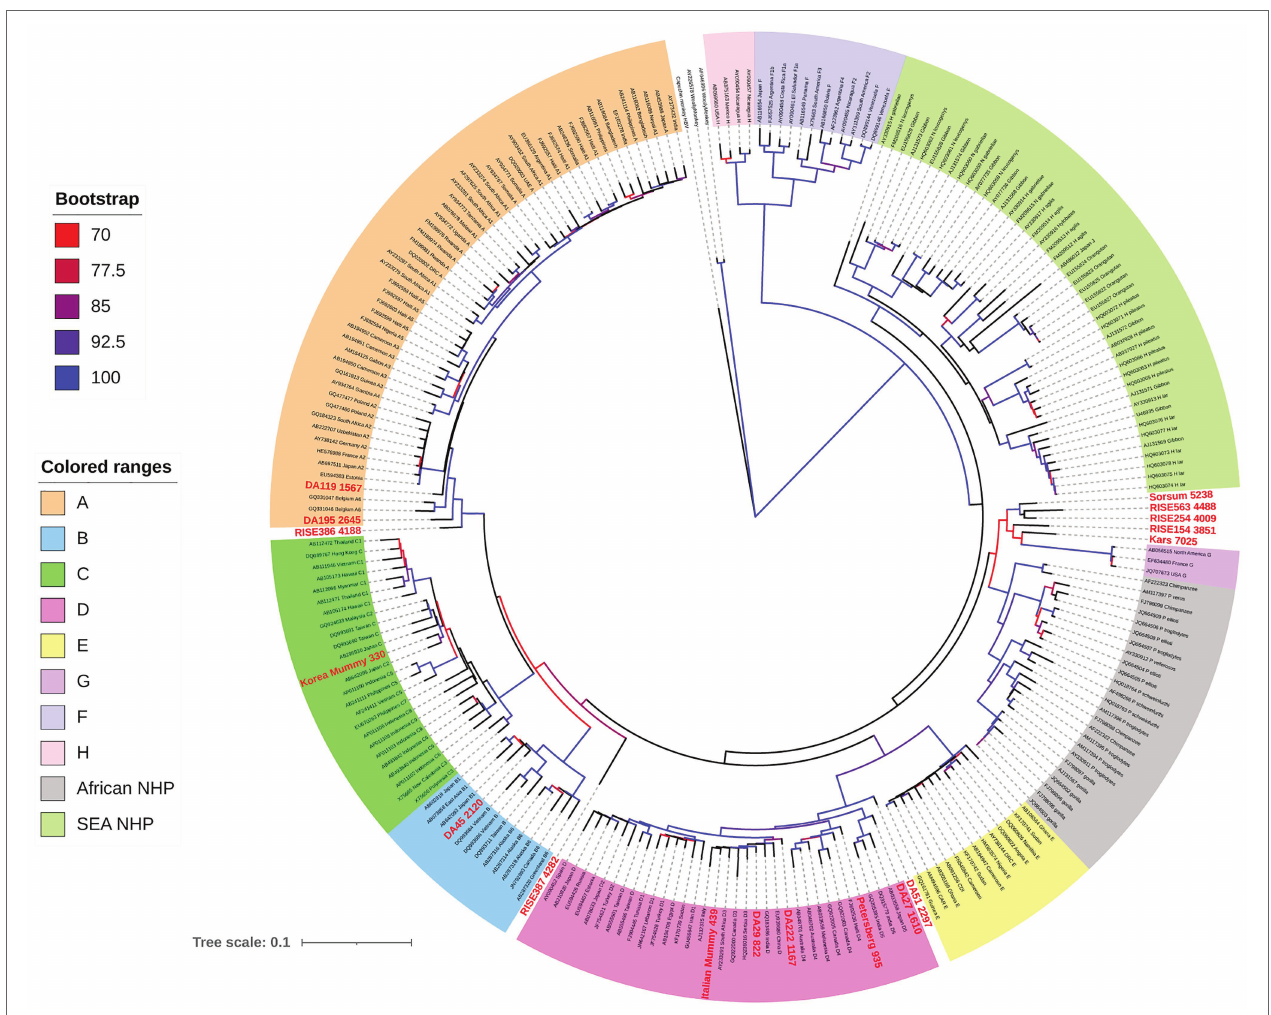
FIGURE 4 | Maximum likelihood (ML) phylogenetic tree of full-length HBV genome sequences (aHBV has shown in bold red font) extracted from human and non- human primate hosts, and reference HBV subgenotype sequences obtained from GenBank. For aHBV, the number after ID represents the approximate age of the source fossil samples. The tree was inferred using IQ-TREE v1.6.5 (Nguyen et al., 2015), which is packaged with ModelFinder (Kalyaanamoorthy et al., 2017) and UFBoot (Hoang et al., 2018). The best-fit model determined by ModelFinder was GTR+F+R5. Clade support was assessed using 1,000 pseudo replicates generated with the UFBoot non-parametric bootstrap procedure, and bootstrap values >70% are shown by a color scale on the tree branches. The ML tree was annotated using iTOL v5.7 (Letunic and Bork, 2019). Branch lengths are scaled to the number of nucleotide substitutions per sequence